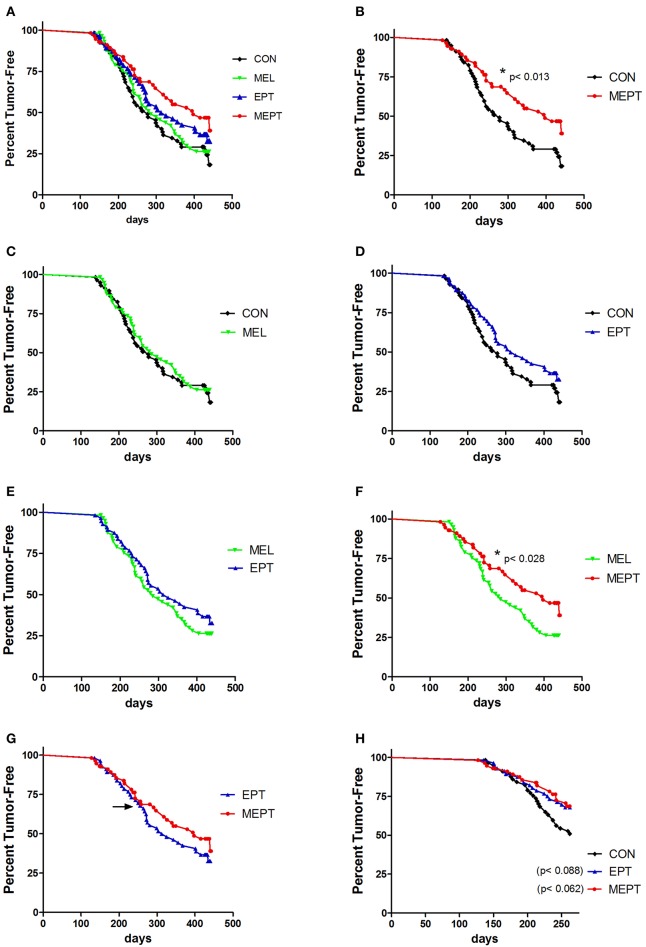
Melatonin-estradiol-progesterone therapy (MEPT) represses the development of primary mammary tumors in MMTV-Neu female mice. Female mice were started on the treatments at age 2 months and tumor onset was determined by weekly palpations starting at 4 months. (A) The Kaplan-Meier (survival) curves for all four groups are shown. (B) The MEPT curve (n = 56) is significantly different than the CON group (n = 57, *p < 0.013, log-rank test). (C) MEL (n = 57) and (D) EPT groups (n = 56) are not significantly different than CON mice and (E) are not significantly different from each other. (F) The MEPT curve is significantly different than the MEL group (*p < 0.028). (G) The MEPT curve was not significantly different than the EPT group by the Log-rank (Mantel-Cox) test. The arrow notes the age (8.6 months) when the curves separate. (H) The decline in tumor-free mice until age 8.6 months for EPT and MEPT mice compared to CON mice are shown (arrow in panel G denotes the maximum age used for these curves). Significance was analyzed separately for EPT and MEPT vs. CON mice, but are shown together in this graph for comparative purposes. Both treatments trended for significance for EPT vs. CON mice (p < 0.088, log-rank test) and MEPT vs. CON mice (p < 0.062, log-rank test). Group abbreviations and their treatments are outlined in Table 1.